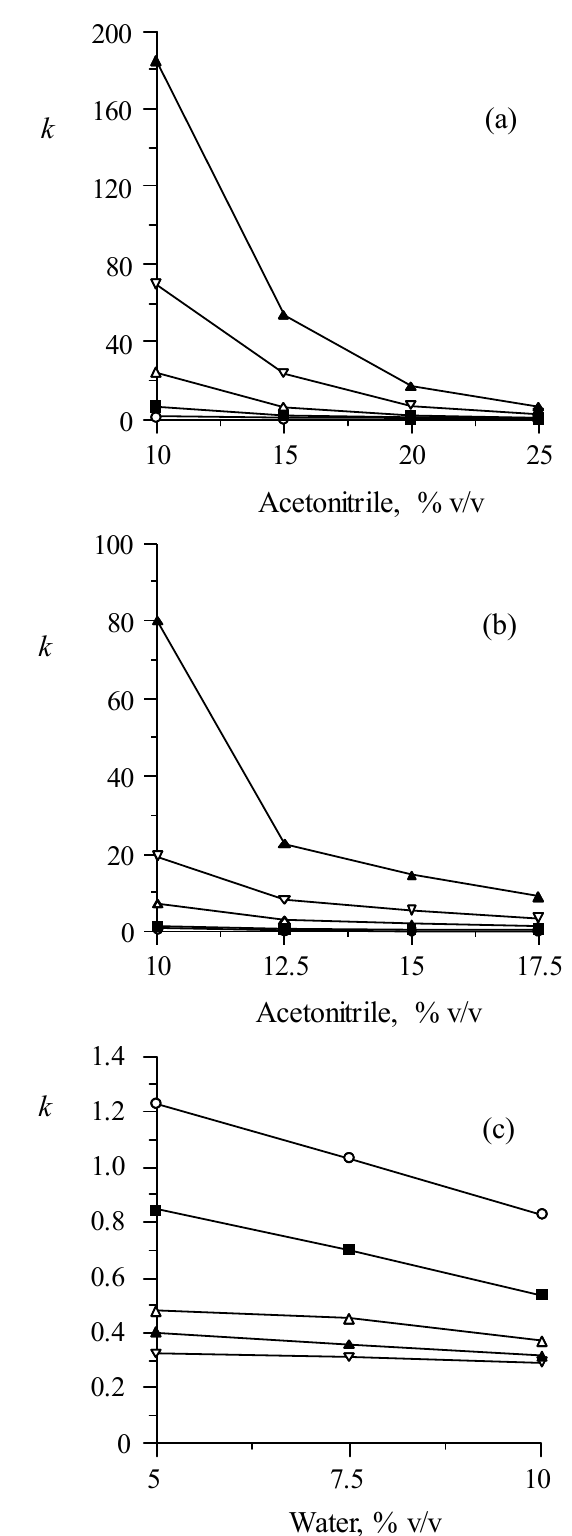
Figure 1. Changes in retention for β-adrenoceptor antagonists with increasing modifier contents in: ( a ) RPLC without IL, ( b ) RPLC with added [C 6 C 1 im]Cl, and ( c ) HILIC. Compounds: atenolol ( ○ ), carteolol ( ■ ), timolol (∆), oxprenolol ( ∇ ), and propranolol ( ▲ ).